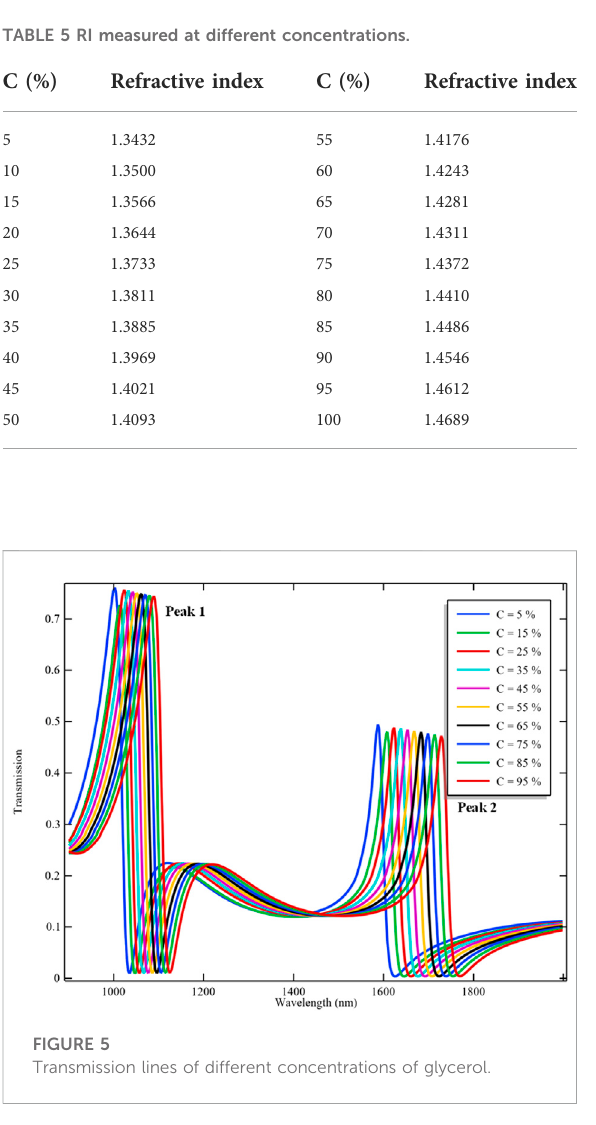
comparison between the actual measured value and the fi tted refractive index, According to (Eq. 7), R 2 = 0.999,998 proves that the fi tting curve we get is well fi tted. The refractive index of glycerin measured by Abbe refractometer can be accurate